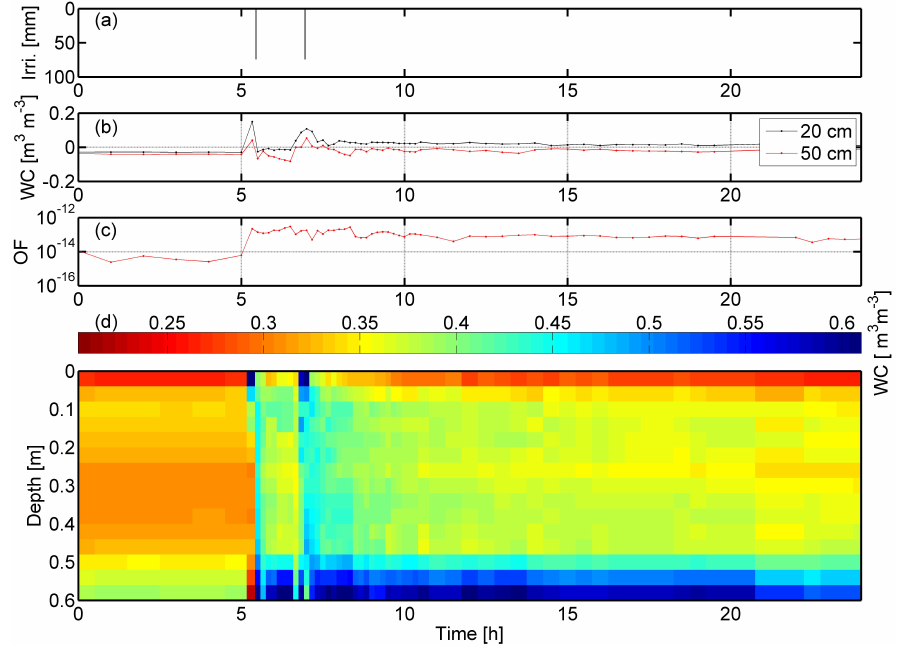
Fig. 9. Inverted soil moisture profiles obtained in an experimental box filled with soil from Rehefeld with (a) the irrigation, (b) the absolute error of inversion compared to measurement with THETA, (c) the objective function (shortened with OF) of the inversion and (d) the inverted profiles to a depth of